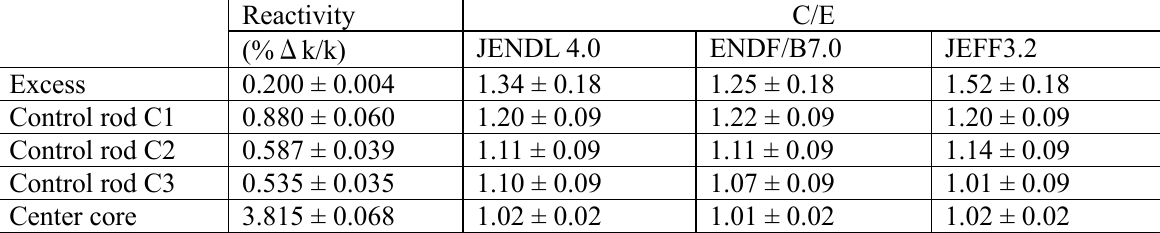
Table II. Measured reactivity worth and C/E value: Errors correspond to 2σ